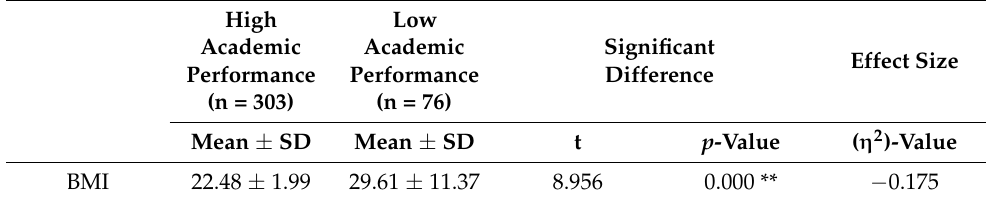
Table 5. Mean ± SD and differences between total BMI scores, and academic performance levels of the study participants (n = 379).